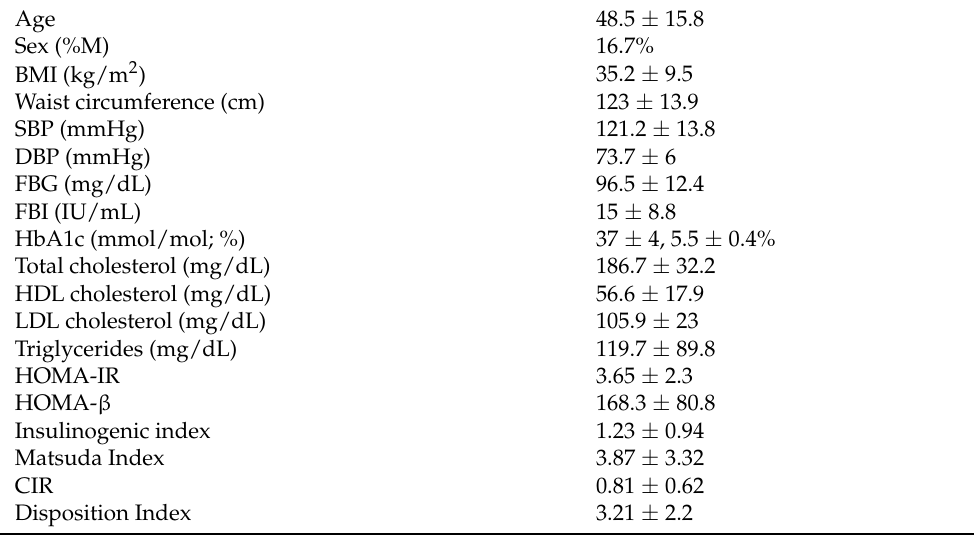
Table 1. Clinical characteristics of the study